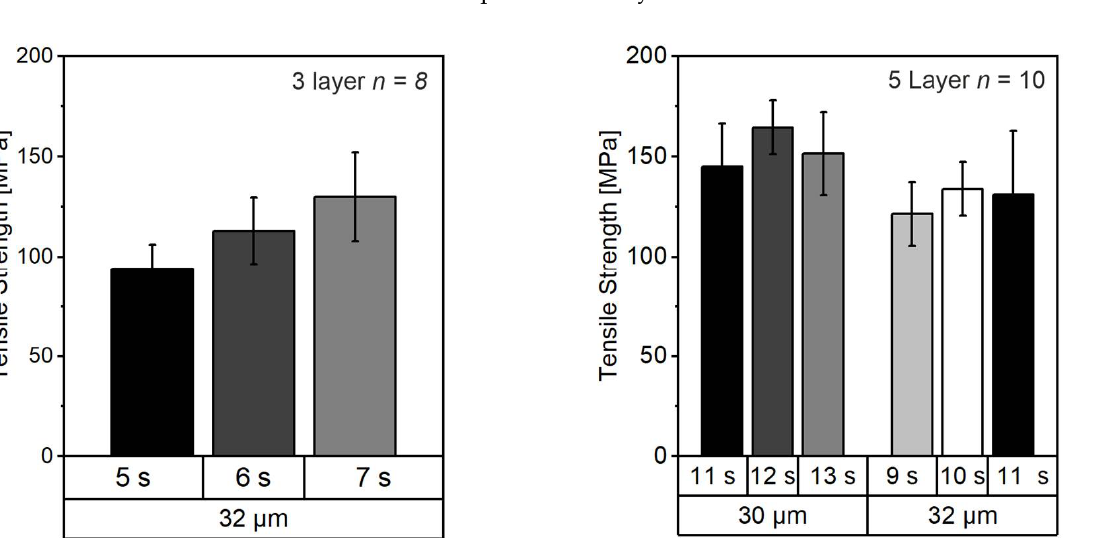
Figure 9. Comparison of tensile strength with different process parameters.